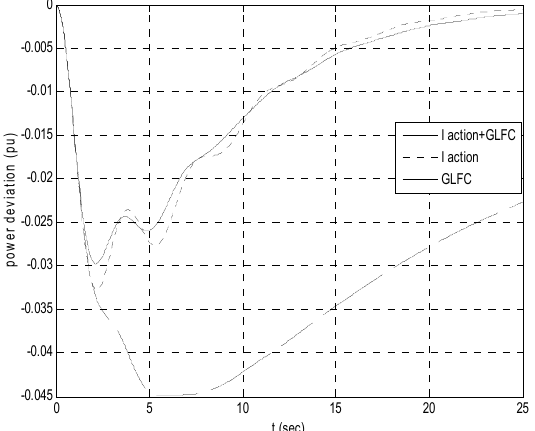
Figure 6. The frequency deviation response in area 2. (At step load change of 187.5 MW in area 1).